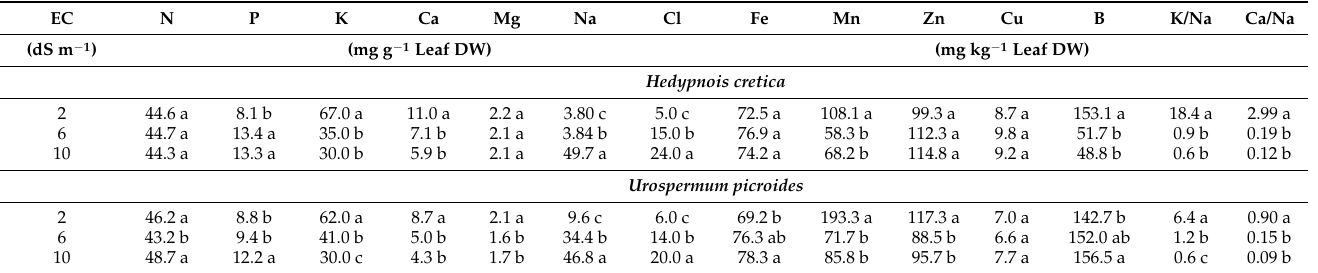
Table 3. Leaf nutrient concentrations of Hedypnois cretica (3a) and Urospermum picroides (3b) plants grown under different nutrient solution EC levels (2, 6, and 10 dS m − 1